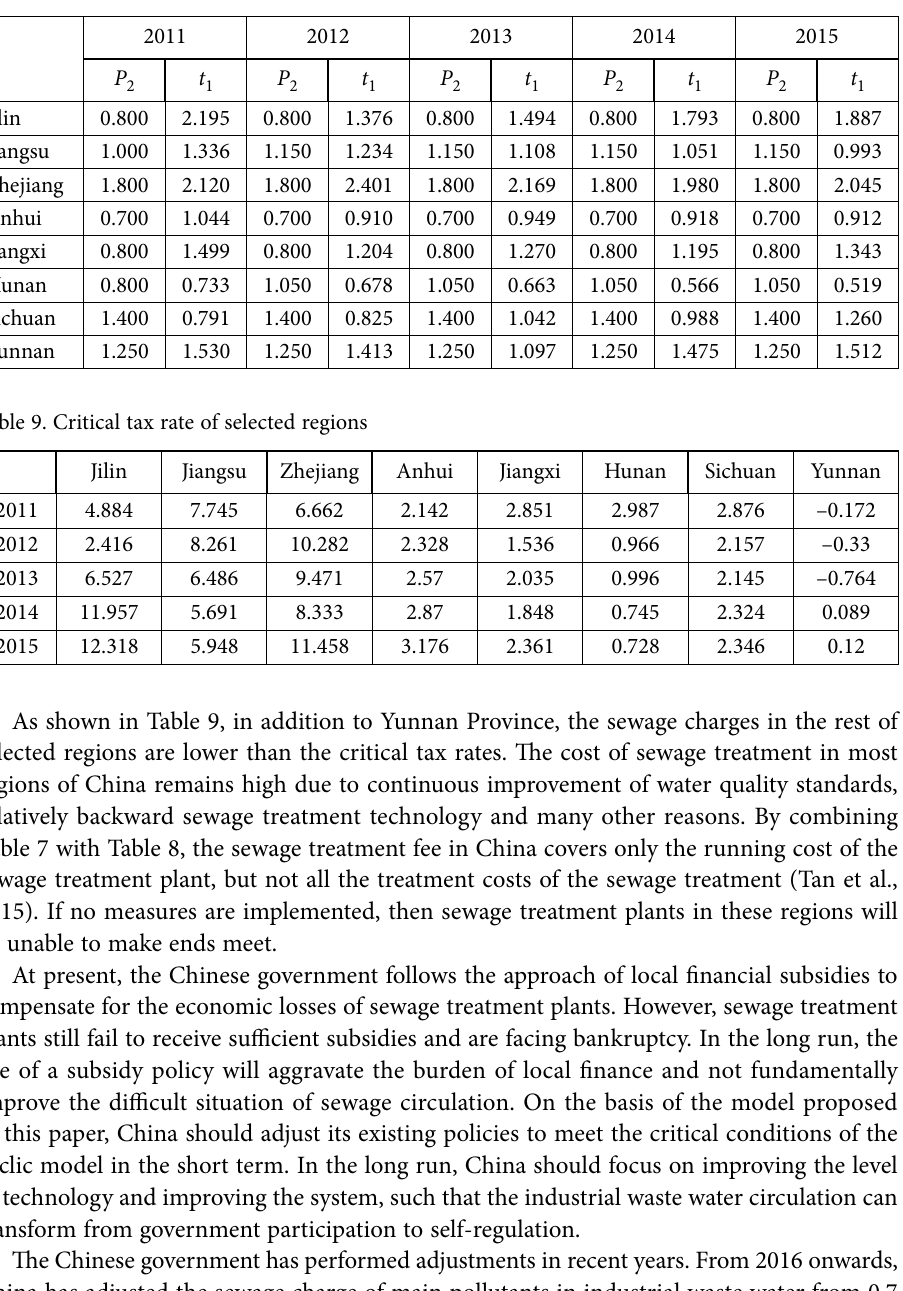
Table 8. Sewage treatment fees and sewage charges